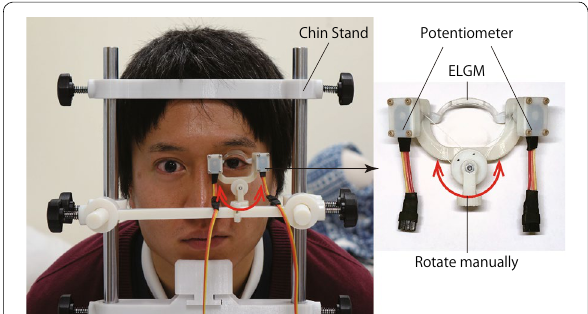
Fig. 8 Experimental set up. Subjects fixed their head on a chin stand on which the ELGM was implemented. The experimenter rotates the ELGM manually to manipulate the subject’s eyelid. We used a camera with a rate of 60 fps, and pictures were extracted from the obtained videos when the potentiometer shows a maximum